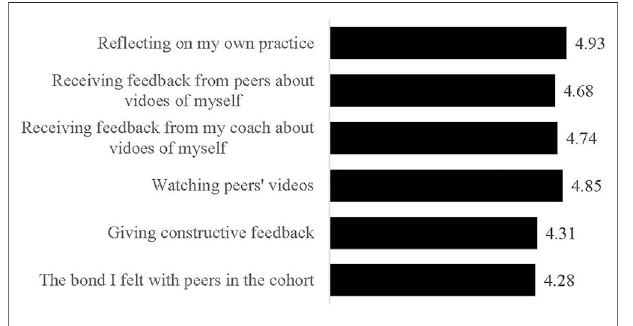
FIGURE 5 | Essential elements ratings, provided by virtualizing